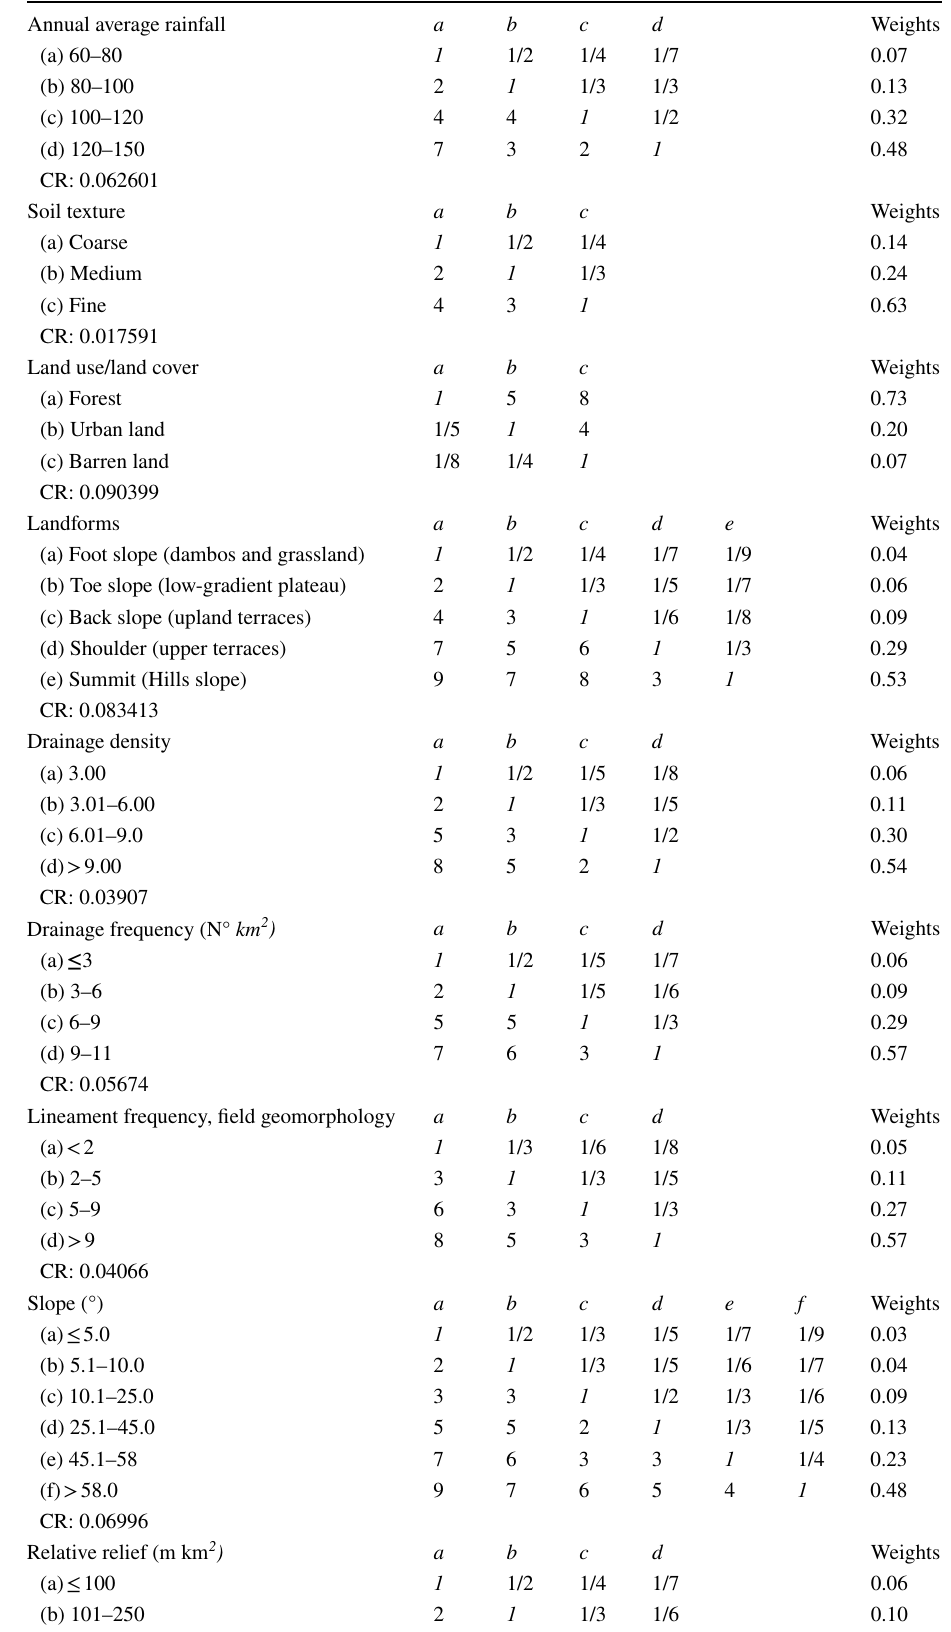
Table 10 Summary of pairwise comparison matrices used for risk mapping/soil erosion